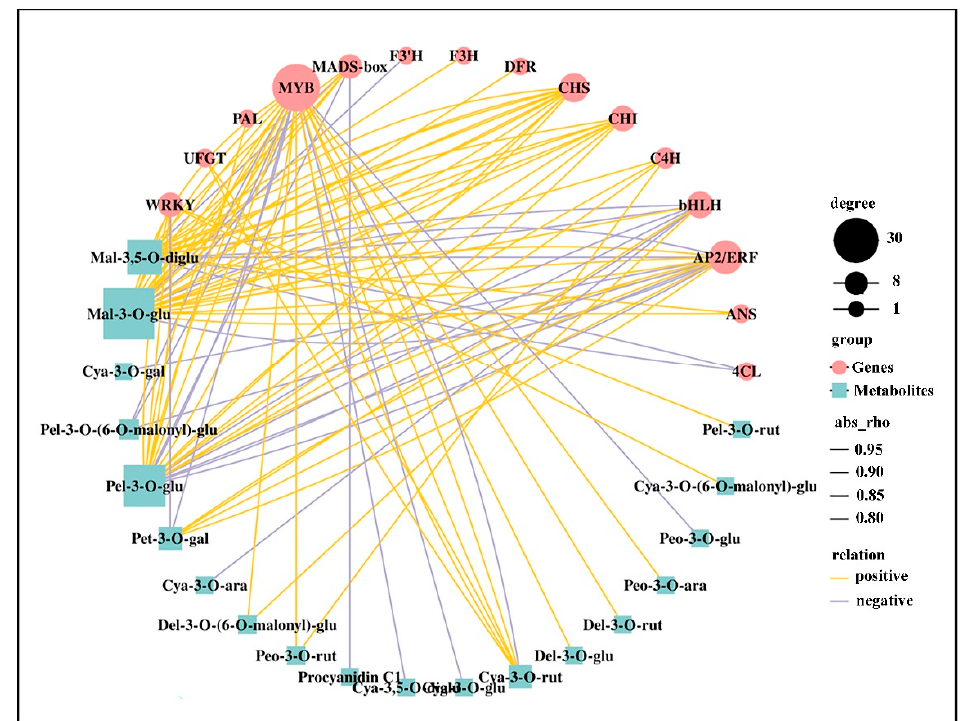
Figure 8. Correlation network of metabolites and genes (15 key genes) involved in phenylpropanoid and flavonoid biosynthesis in GL vs. PRL. Abs_rho represents the Pearson correlation coefficient (r). Degree represents the gene number. Relation represents the correlations with a coefficient (r) value > 0.8 (positive) or < -0.8 (negative). PAL, phenylalanine ammonia-lyase; C4H, cinnamic acid